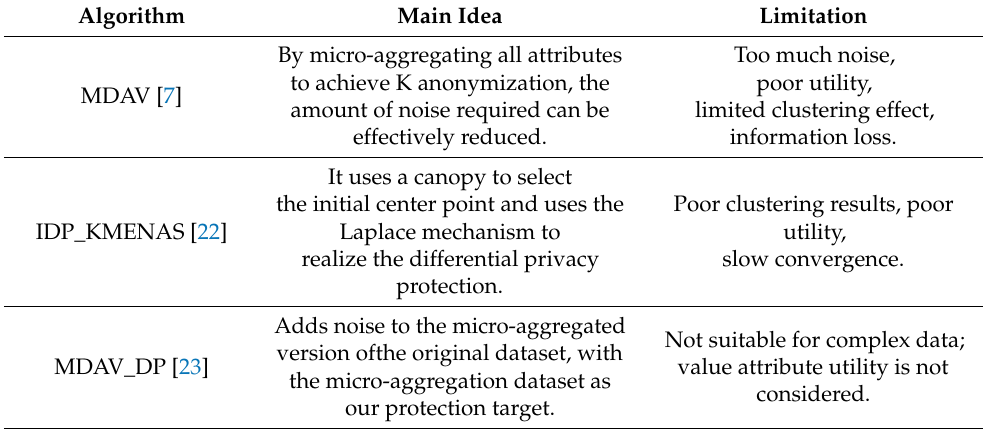
Table 1. Contrast